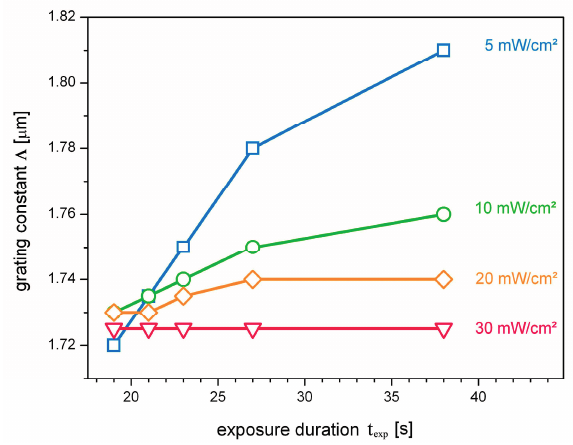
Figure 2. ( a ) Impact of the exposure duration on the grating period: Λ ( t exp ) for various recording intensities, derived from lateral scans. The strongest dependency is obtained in case of low recording intensity ( I = 5 mW/cm², blue squares). An increase of the recording intensity progressively reduces the impact of the exposure duration: from ( I = 10 mW/cm², green circles) to ( I = 20 mW/cm², orange diamonds) up to ( I = 30 mW/cm², red